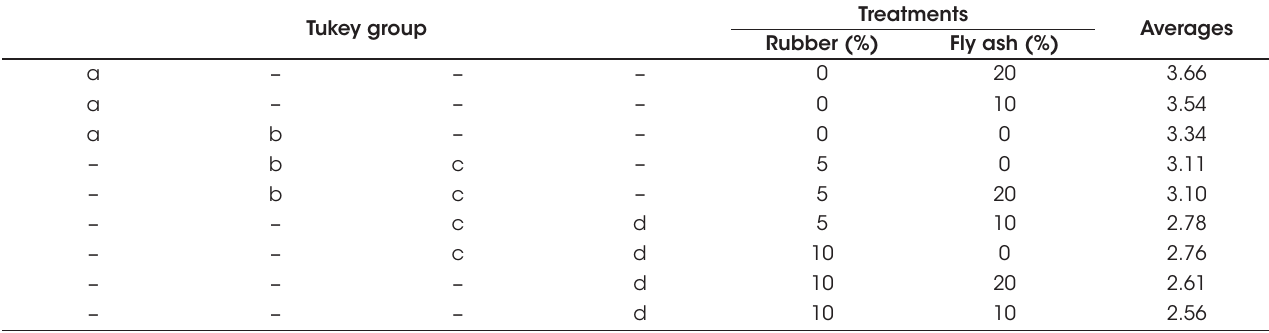
Tukey test results for mortar compressive strength Tukey group